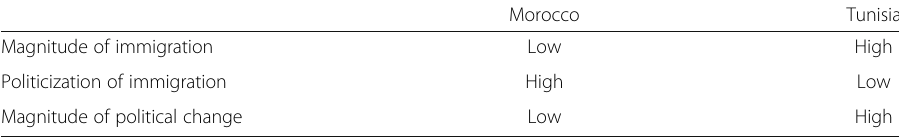
Table 2 A dual paradox in Moroccan and Tunisian immigration